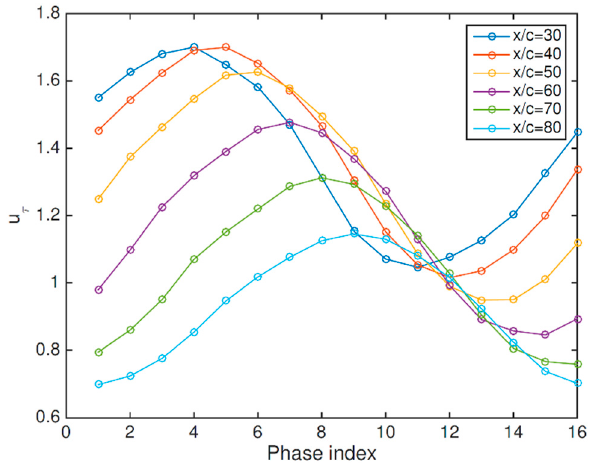
Figure 27. Friction velocity for each phase at every chordwise location.